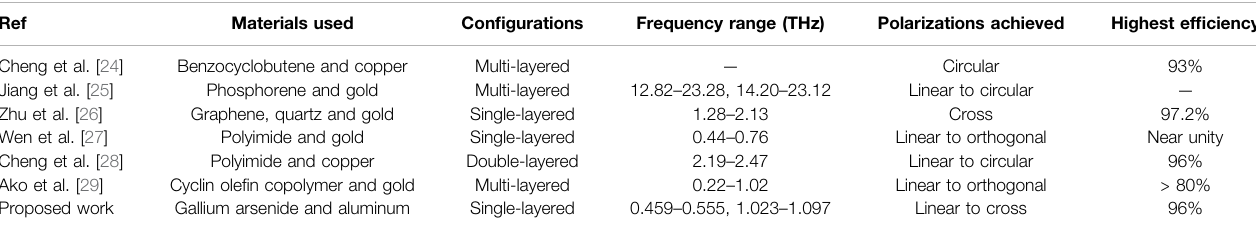
TABLE 2 | Comparison of the proposed work with the existing